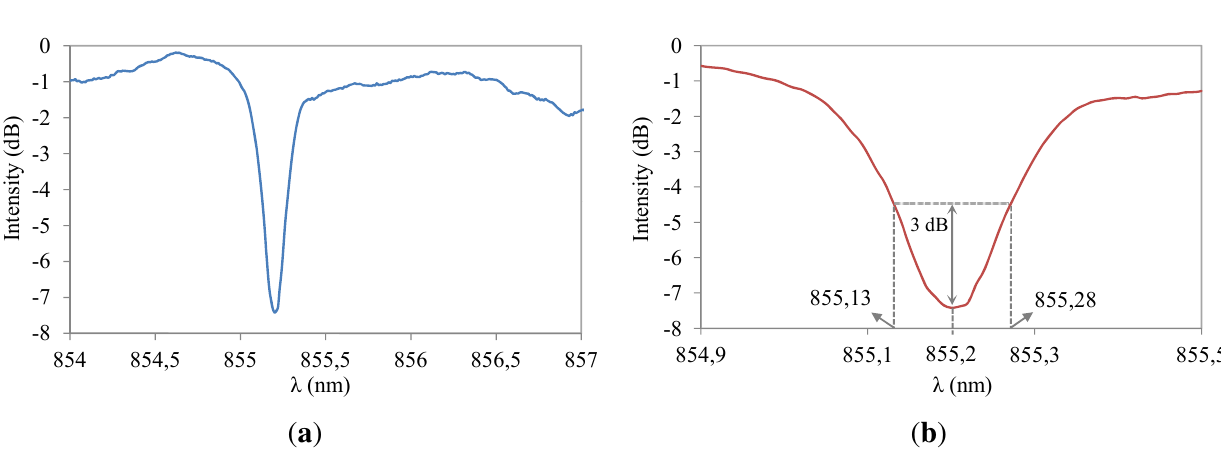
Figure 1. Typical spectral response of the fabricated fiber Bragg gratings at 850 nm, measured in transmission with an optical spectrum analyzer. ( a ) Normalized transmission spectrum of the grating; ( b ) Detailed view indicating the 3 dB wavelength range in